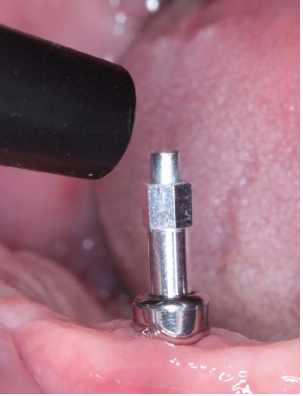
Figure 2. Transepithelial abutment and SmartPeg screwed onto de implant.